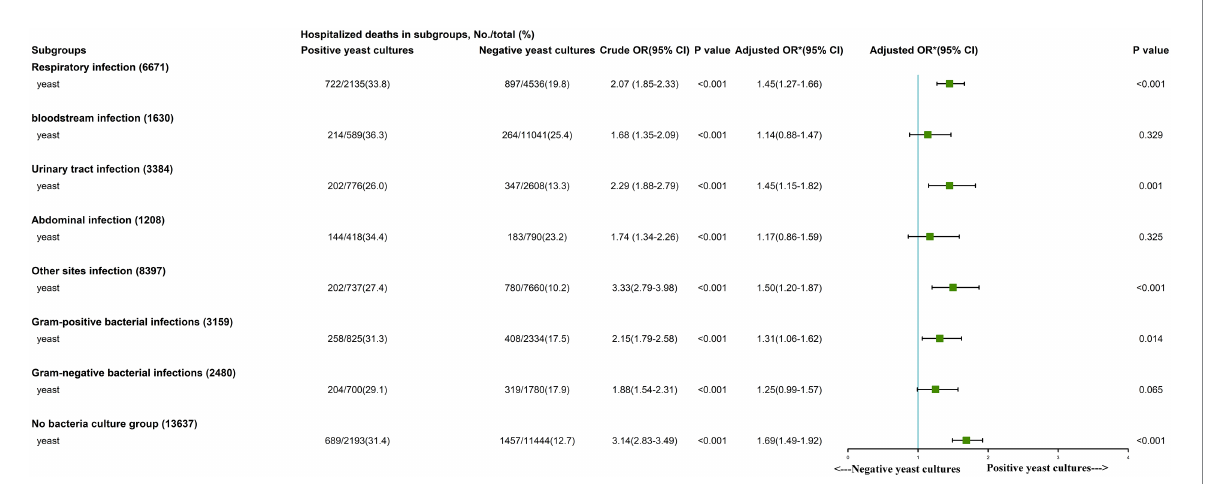
FIGURE 2 Subgroup analysis of the association between in-hospital mortality and early Positive yeast cultures. *We adjusted age, gender, ethnicity, insurance, weight, source of admission, history of disease, Sequential Organ Failure Assessment (SOFA) score, vital signs, laboratory outcomes, in-hospital management and only later antifungal